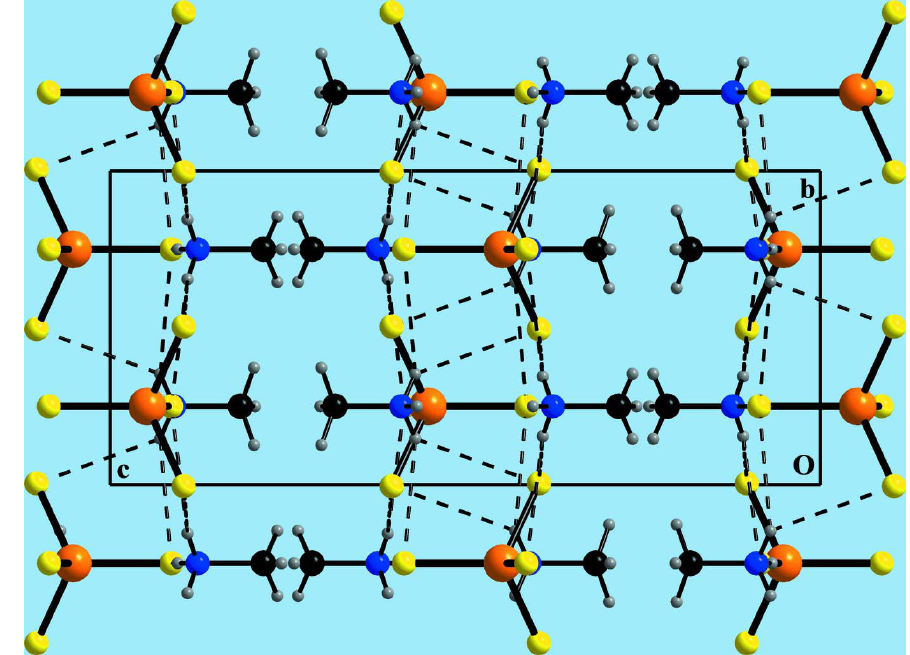
Figure 3 A view of the crystallographic packing of the title compound along the a axis, showing the organization of the organic cations and [WS ] 2- anions. H-bonds are shown as broken 4